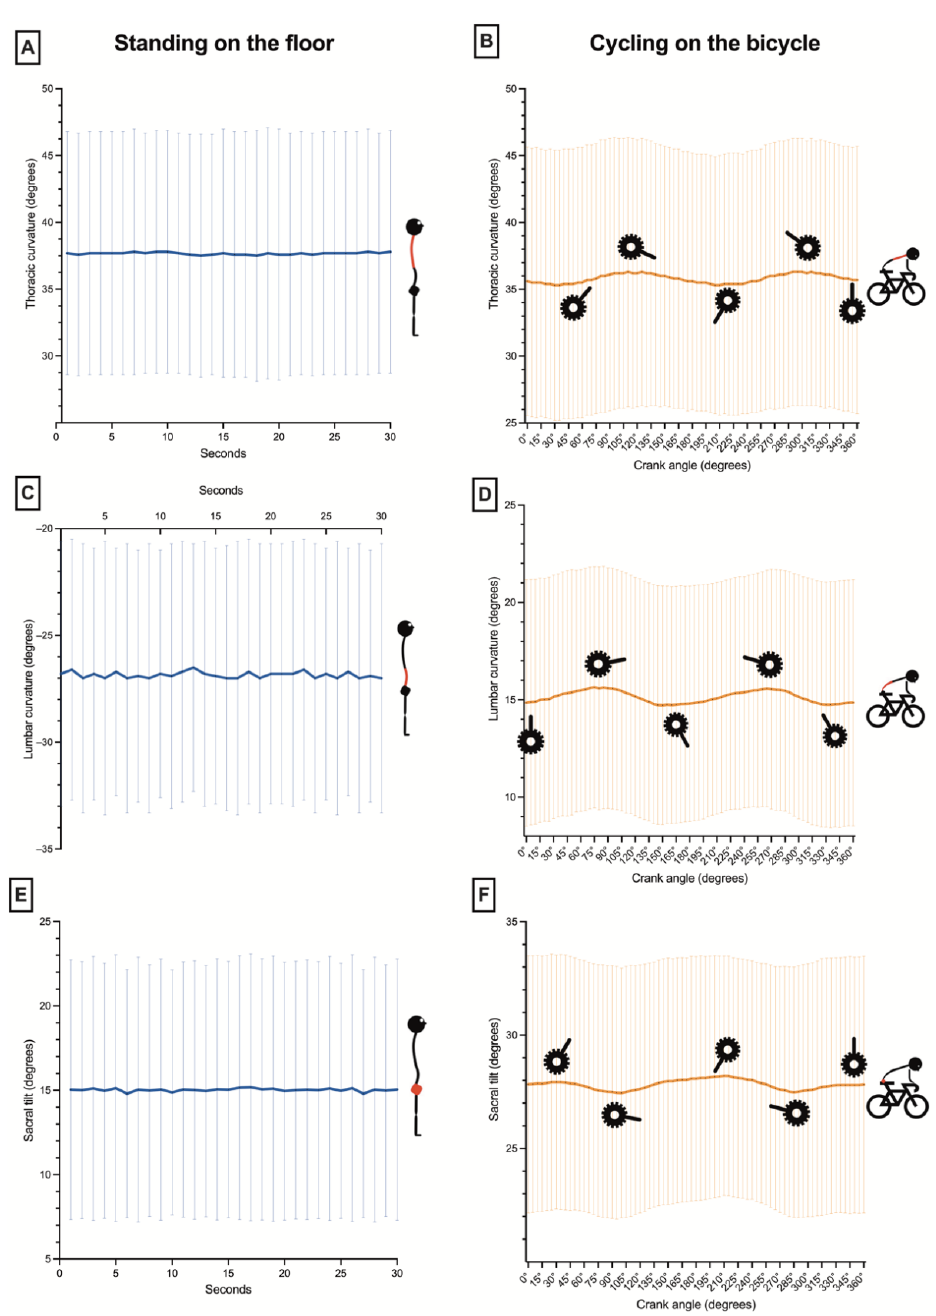
Figure 2. Average angles and standard deviation of the spinal curvatures and the sacral tilt, for the 12 cyclists, in standing on the floor and pedaling on the road bicycle.